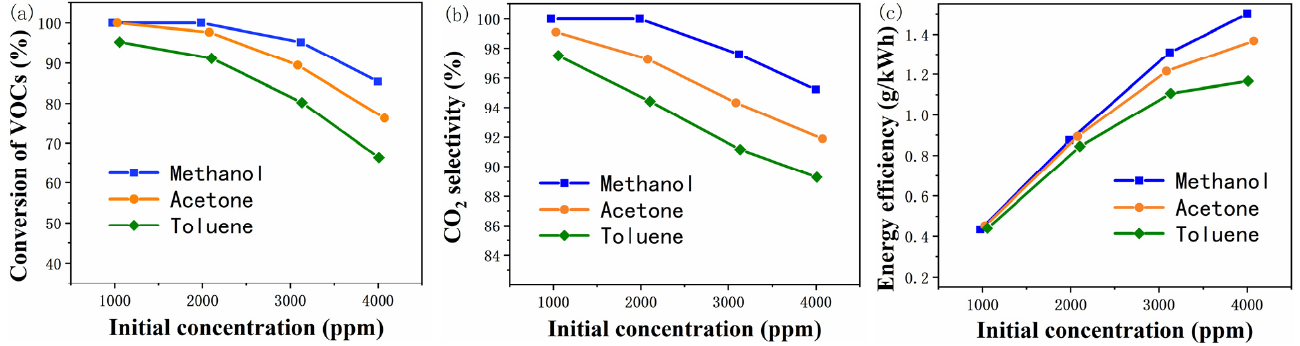
Figure 2. Effect of initial concentration on ( a ) conversion, ( b ) CO 2 selectivity, and ( c ) energy efficiency by sample Mn/ZSM ‐ 5 ‐ N.